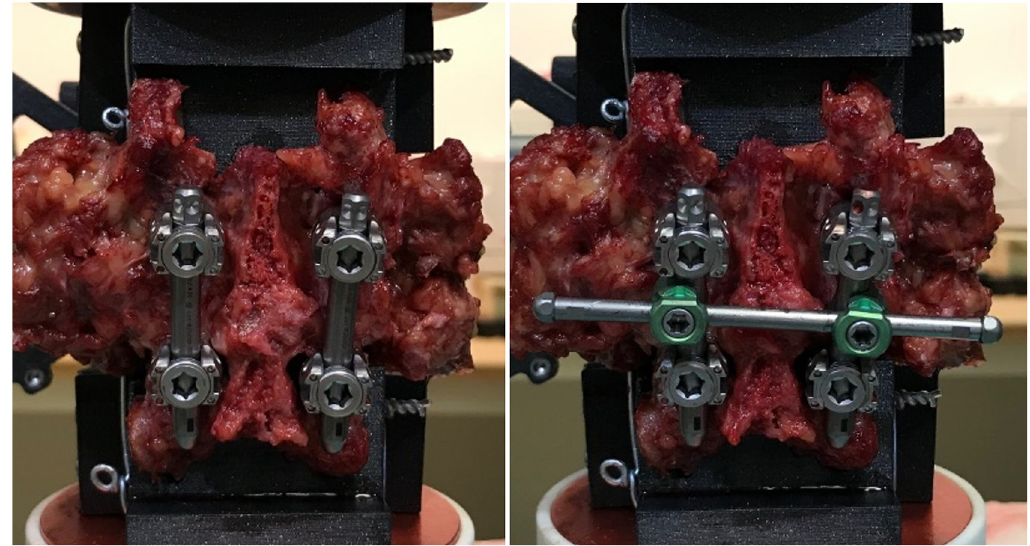
Fig 3. Cross-connector. CBT screw-rod construct without horizontal cross-connector (left) and augmented with one horizontal cross-connector (right). Figure generated by the authors.